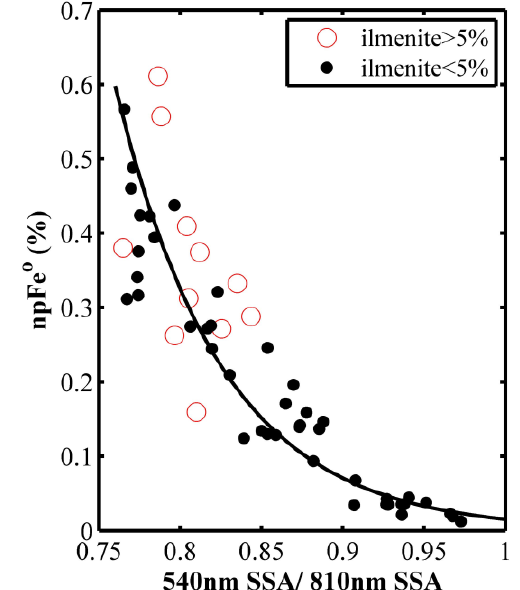
Figure 7. Correlation between the ratio of 540 nm SSA/810 nm SSA and npFe 0 denoted by different groups of LSCC lunar samples with varying ilmenite content. Solid black line is the regression line defined in Figure 4.